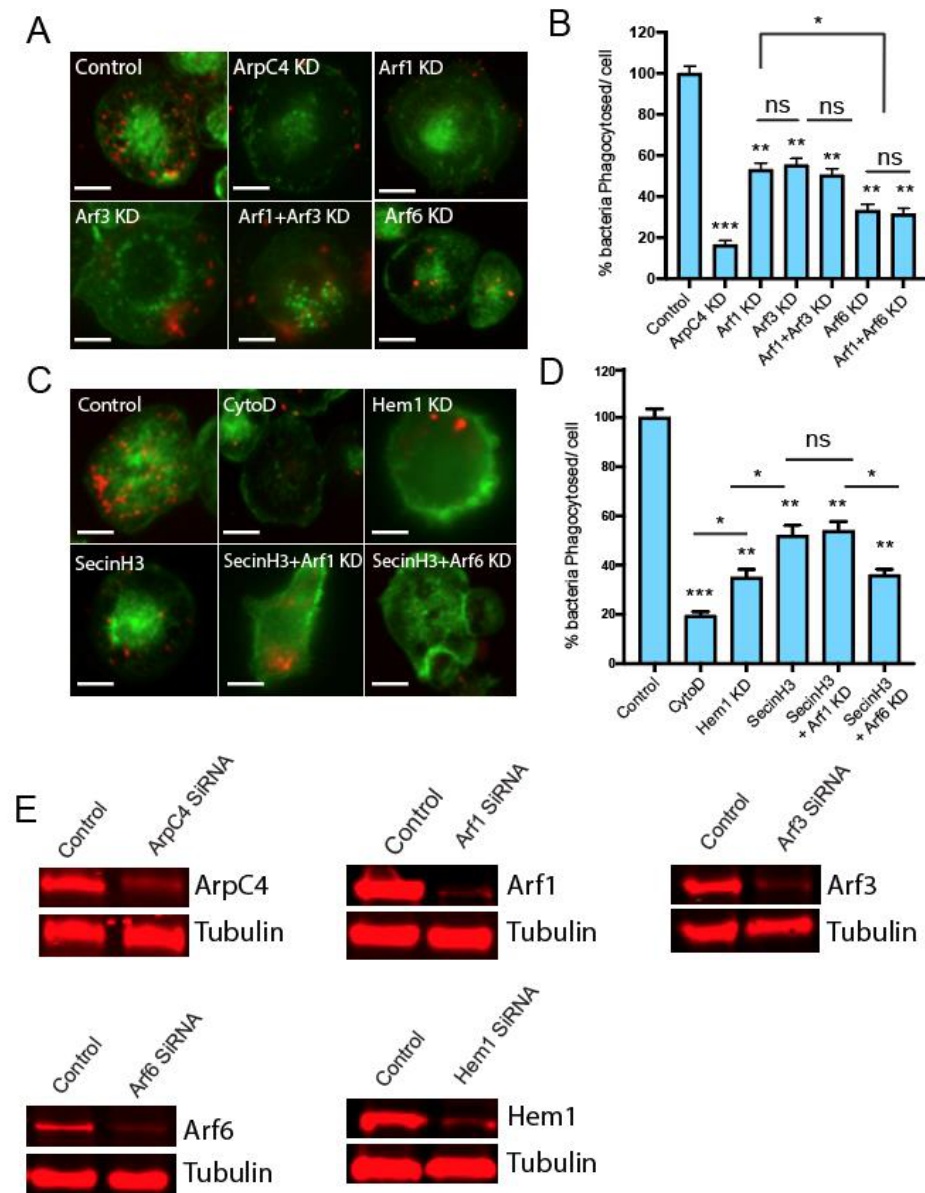
Figure 3. ( A ) Microscopy images depicting phagocytosis of labelled E. coli particles by PMA differentiated THP-1 macrophages (control) or upon silencing ArcC4, Arf1, Arf3, Arf1& Arf3, or Arf6 using siRNA. Internalized bacteria are shown in red while actin is stained using phalloidin (green). ( B ) Quantification of the phagocytosed E. coli by THP-1 macrophages as described in ( A ). Phagocytosis of phRodo-conjugated E. coli particles in THP-1 macrophages (control) or upon using actin inhibitor (CytoD), Arno inhibitor (SecinH3), or silencing of Arf1 or Arf6 in Arno-inhibited cells. Scale bar 10 µm ( D ). Represents quantification of the percentage of internalized bacteria under conditions as described for ( C ). ( E ) Immunoblot confirming the silencing of the mentioned proteins using SiRNA. Each bar represents the average of results from 3 separate experiments, and error bars represent SD, *** p < 0.001; ** p < 0.01; * p < 0.05; ns, not significant (one-way ANOVA followed by a post hoc Dunnett comparison) relative to the equivalent strain on WT THP-1 control cells. Lines indicate significance between pairs of conditions determined by Student’s t